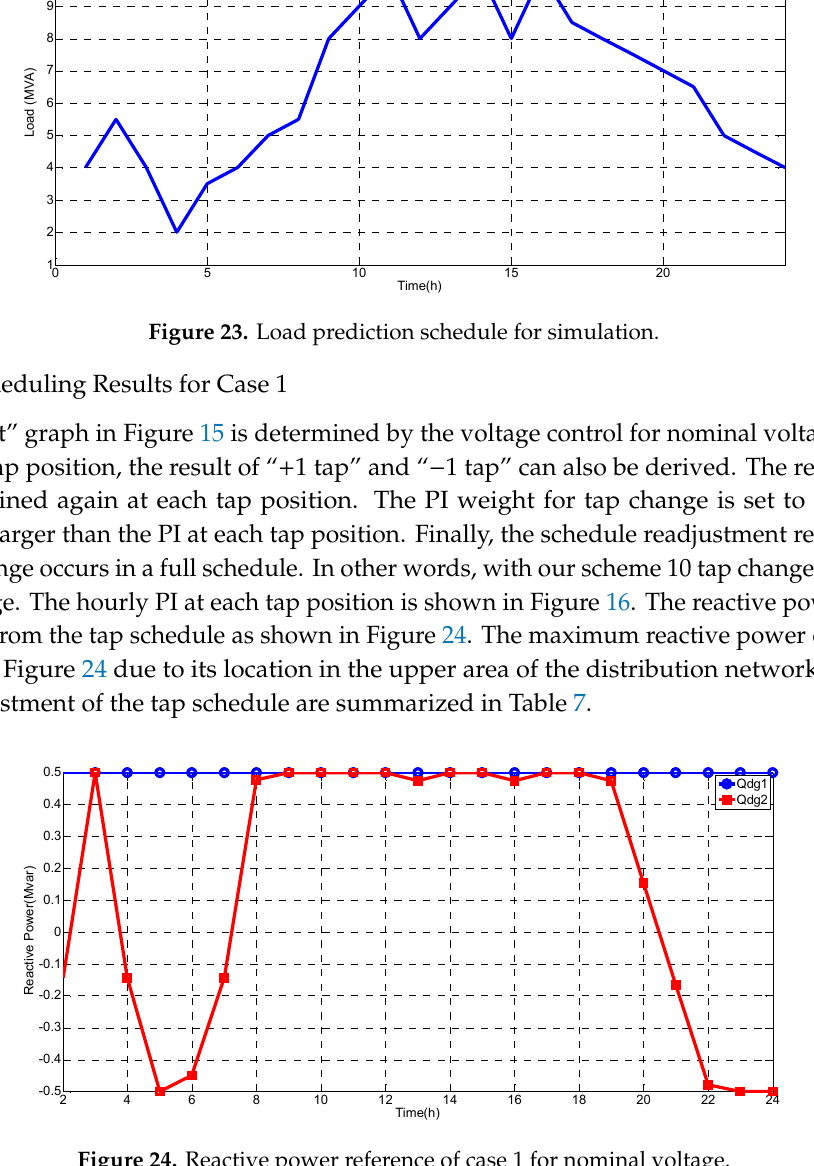
Figure 22. Comparison of optimal and proposed voltage profile for CVR in case 2.